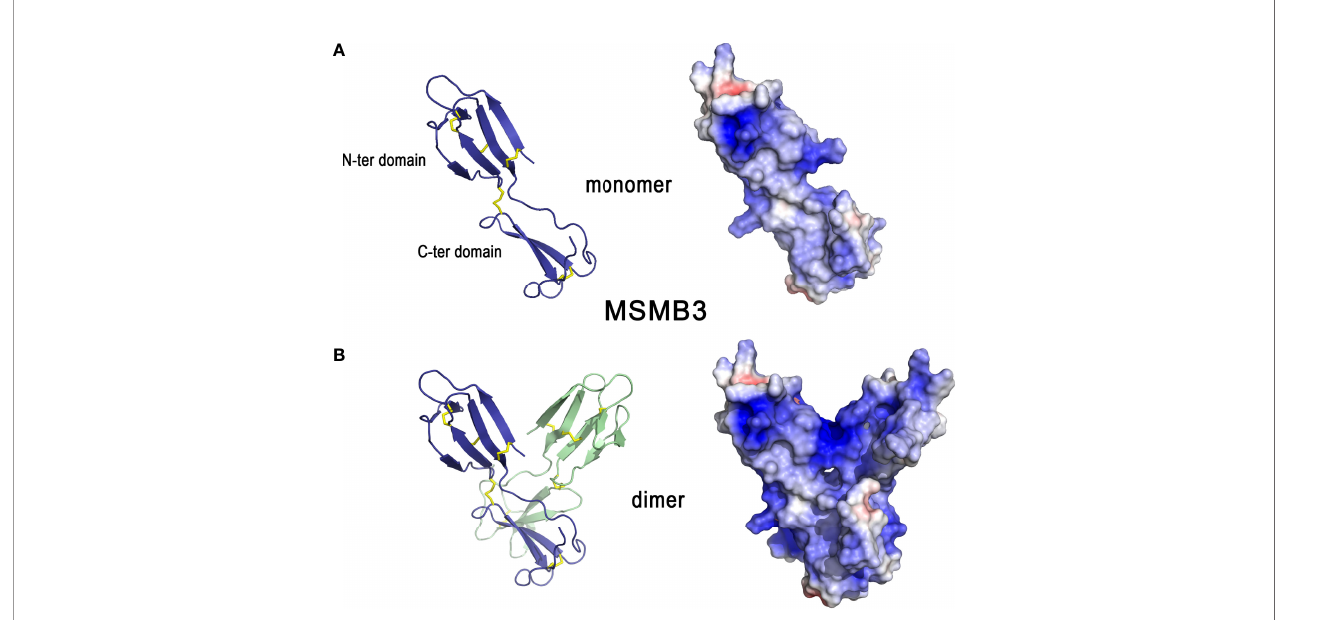
FIGURE 10 | 3D structures of b -microseminoprotein-like MSMB3. 3D structure of chicken MSMB3 monomer (A) and dimer (B) . The left panels correspond to the cartoon representation of 3D structure while the right panels show the color-coded electrostatic potential molecular surface. Color scheme ranges from red (negatively charged regions) to deep blue (positively charged regions). The fi gure was prepared using Pymol software (48) and APBS (Adaptive Poisson-Boltzmann Solver) plugin (49) for electrostatic calculations using atomic coordinates of 6RWC PDB fi